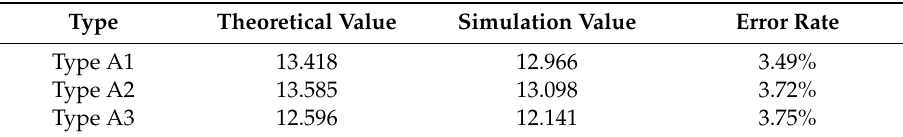
Table 5. Comparison of theoretical and simulation values of types A1, A2 and A3.